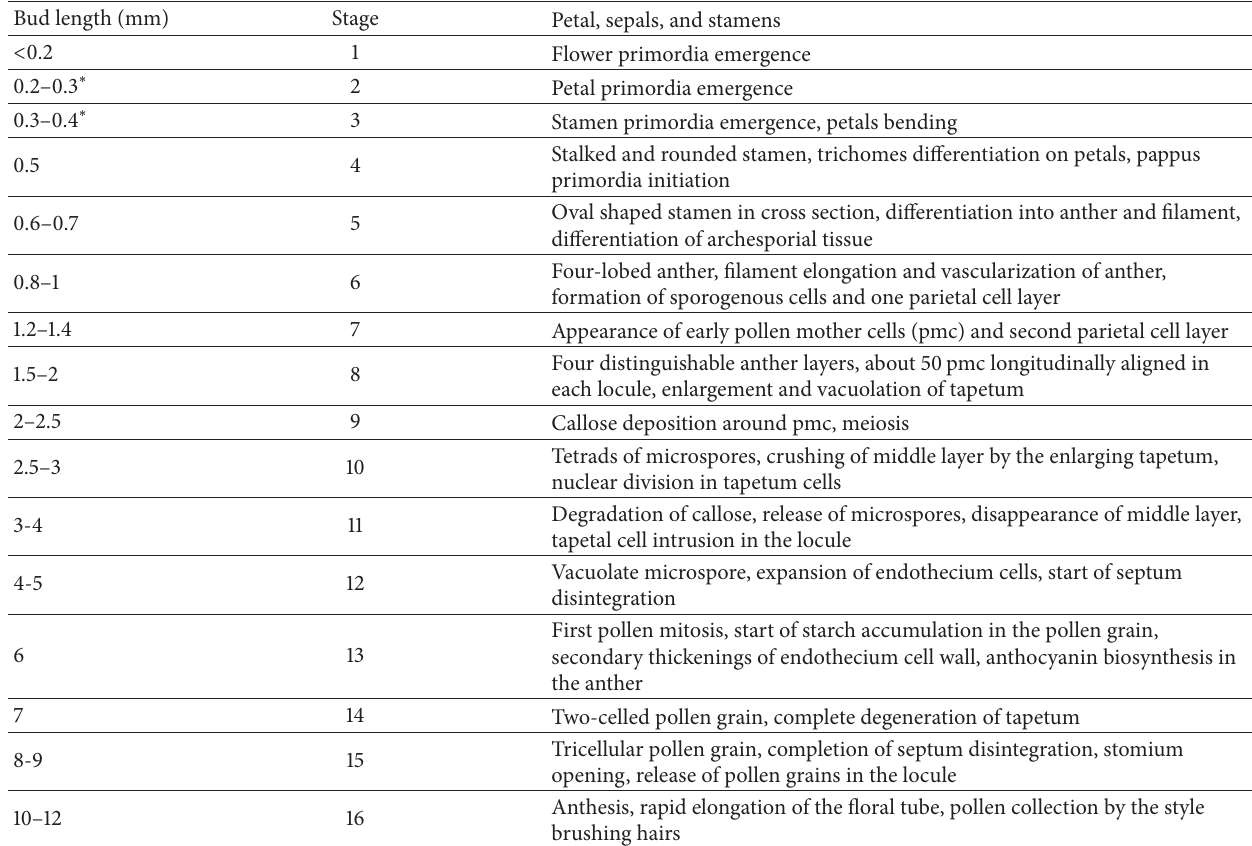
Table 2: Development of male gametophytes in relation to their size and